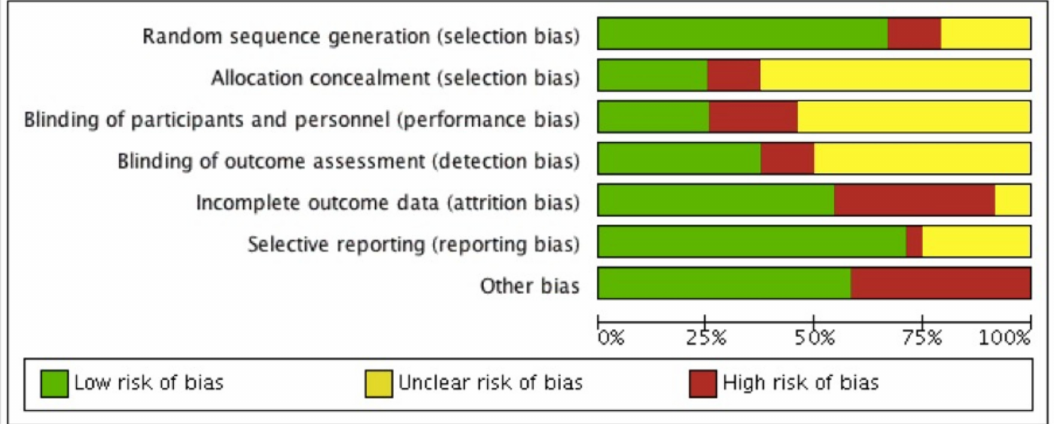
Figure 3. Risk of bias